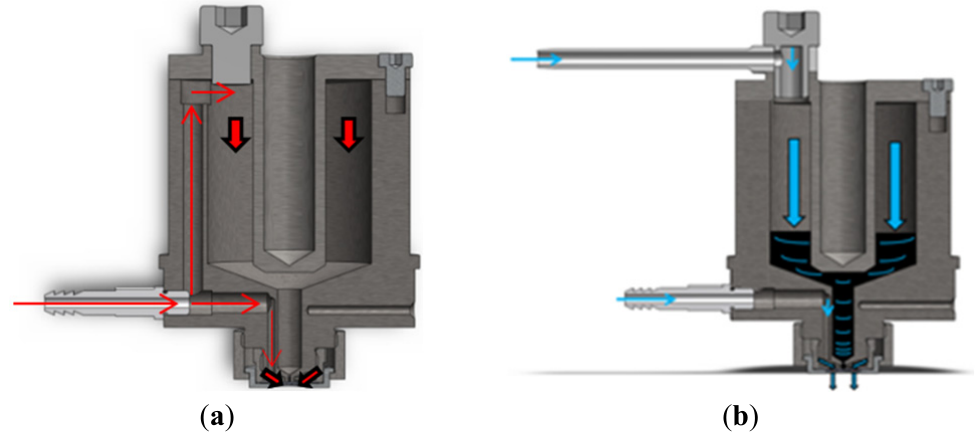
Figure 8. ( a ) Model cross section view of the StarJet V2 with a single gas supply for “single channel” operation; red arrows indicate the pneumatic gas flow. ( b ) Model cross section view of the StarJet V2 with two channel gas supply; blue arrows indicate the pneumatic gas